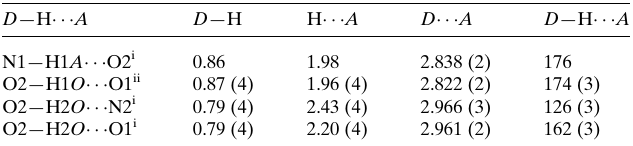
Table 1 Hydrogen-bond geometry (A˚ , (cid:3) ).